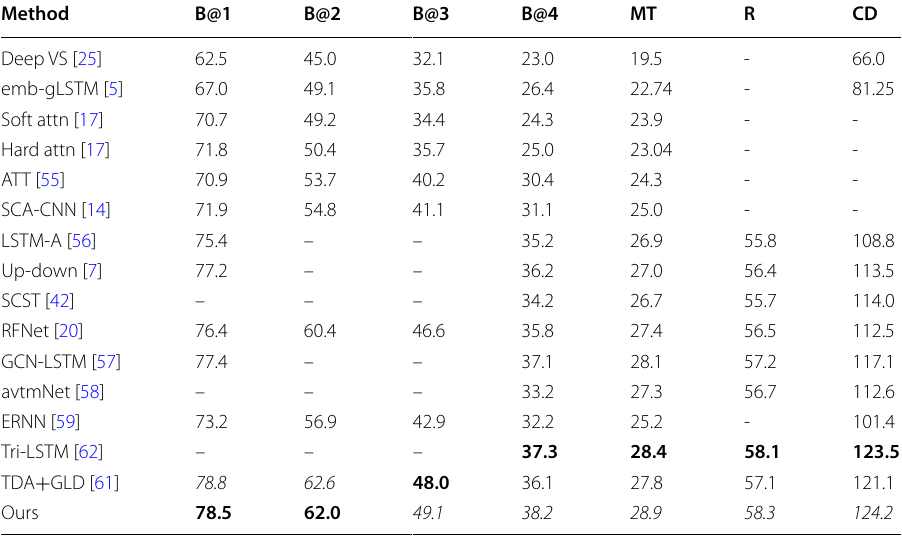
Table 4 Performance comparison of the proposed method on MSCOCO dataset. (-) indicates ‘metric is not reported’. The best two models having larger values of the metrics are shown in red and green